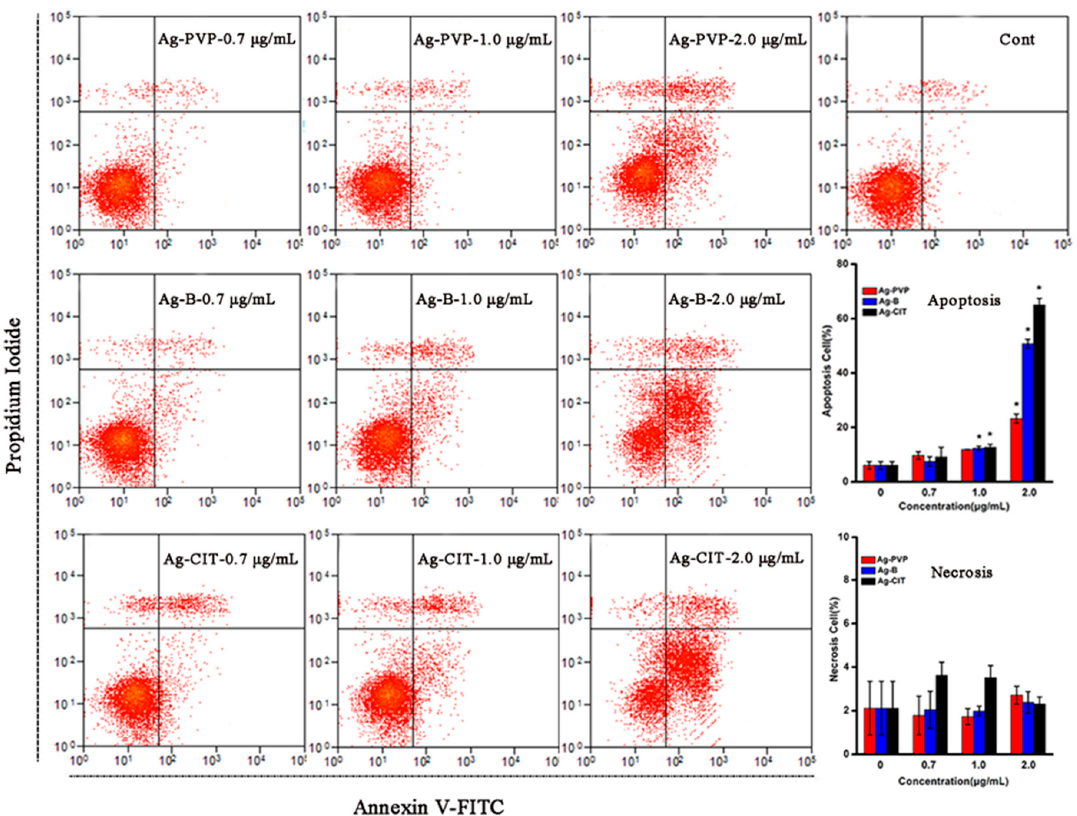
Figure 4. FACS scatter diagrams of Caco-2 cells by the Annexin V-FITC and PI assay. Caco-2 cells had been exposed to three Ag NPs with different concentrations for 24 h. For the histograms, all data are represented as the mean ± SD ( n = 3). * p < 0.05 comparing with the 0 μ g/mL control.